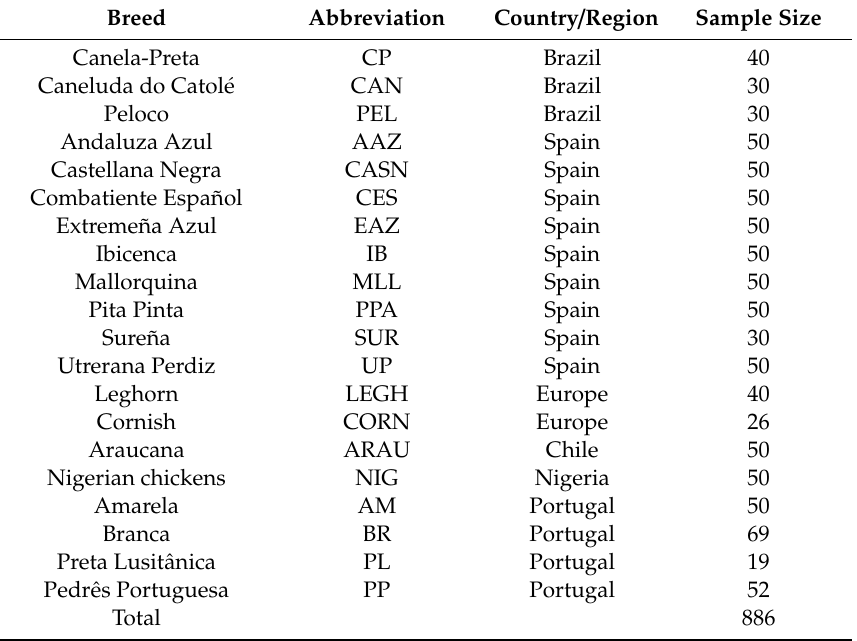
Table 1. Chicken breeds used for assessment of identity and genetic relationships. Breed Abbreviation Country/Region Sample Size